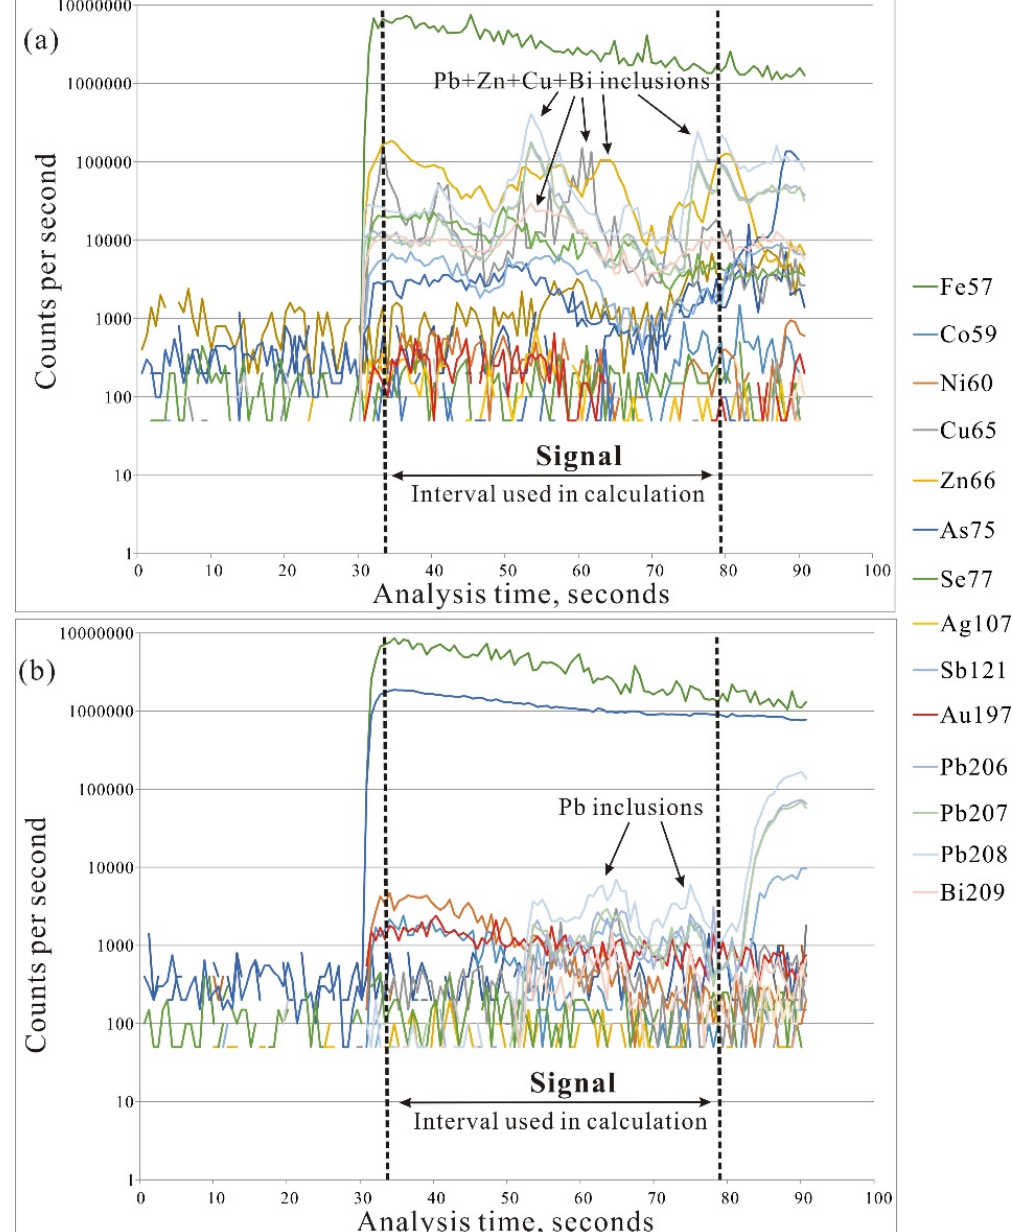
Figure 12. Time-resolved record of the signal recorded on the LA-ICP-MS (in counts per second) during a single analysis. ( a ) PyI-low Au and As, but Pb + Zn + Cu and Bi-bearing inclusions; ( b ) PyII-high contents of Au, As, Ni, and Pb-bearing inclusion.